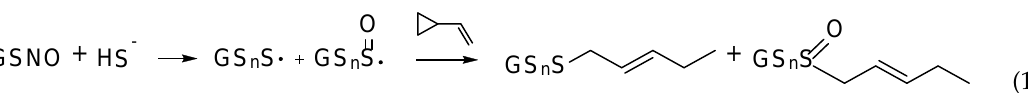
Figure 10. Relative distributions of DH trapped GSS n D, acetamide trapped GSS n A, and oxidized GSS n G species determined from LCMS study of reaction of GSNO (1 mM) with Na 2 S (1 mM) and radical clock vinylcyclopropane (5 mM) in iP buffer at pH 7; (filled squares) in the presence of DH (5 mM), (filled circles) in the presence of IA (5 mM); (open squares) in the presence of DH and vinylcyclopropane, (open circles) in the presence of IA and vinylcyclopropane, and (filled diamond) in the presence of only